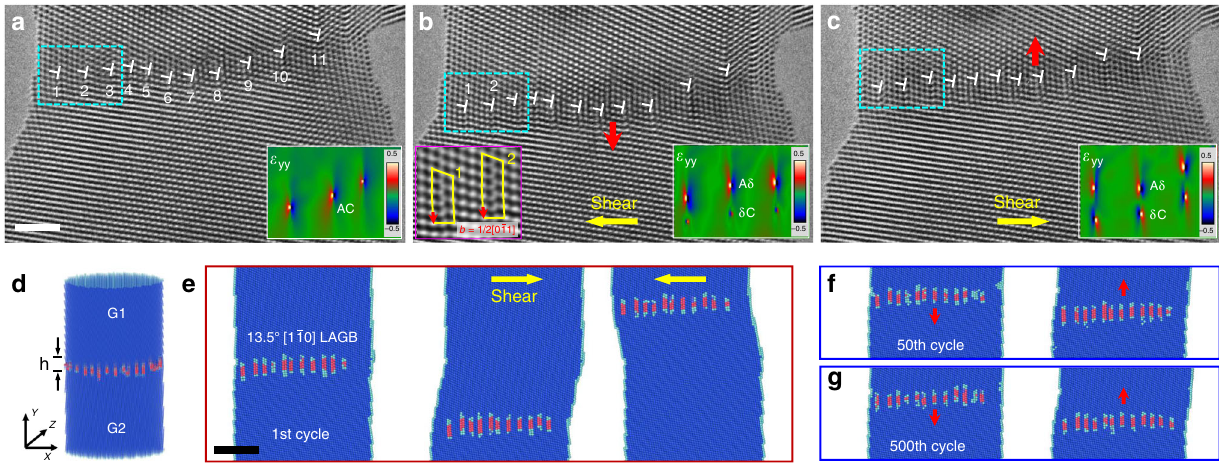
(cid:1) (cid:3) -- Fig. 2 Dissociation of the 13.5° 1 10 LAGB in fully reversed loading cycles. a – c Zoomed-in deformation snapshots showing the atomistic structure of the migrating 13.5° 1 (cid:1) 10 ½ (cid:2) LAGB in reversed shear loading. a Initial LAGB, consisting of well-aligned 1/2 01 (cid:1) 1 ½ (cid:2) dislocations with negligible dissociation. b , c GB migration associated with evident dissociations under leftward ( b ) and rightward ( c ) shear loading. The insets in a – c exhibit geometrical phase analysis (GPA) maps of the vertical normal strain ( ε yy ), demonstrating the dissociation of GB dislocations 1 – 3, as marked by the light blue rectangles. The zoomed- in TEM image in b shows the atomistic core structure of dissociated GB dislocations 1 and 2. d Perspective structure of a fully relaxed Au bicrystal with a dissociated 13.5° 1 (cid:1) 10 ½ (cid:2) LAGB (indicated by the arrows) constructed in molecular dynamics (MD) simulation at 300 K. The diameter and length of the bicrystal are 15 and 30 nm, respectively. e MD simulation snapshots demonstrating the reversible migration of the 13.5° 1 (cid:1) 10 ½ (cid:2) LAGB in a shear loading cycle. f , g Reversible deformation of the Au bicrystal with the 13.5° 1 (cid:1) 10 ½ (cid:2) LAGB in long-time shear loading cycles. The MD snapshots present well-retained LAGB- mediated reversible deformation in the f 50th and g 500th shear cycles, respectively. The cyan and red atoms indicate the Shockley partial dislocations and the stacking fault ribbons, respectively. Scale bars: a 2 nm and e 5 see inset of Fig. 2a). Upon deformation, the GB dislocations TEM image and evident strain dipoles in the corresponding GPA tended to dissociate into pairs of Shockley partial dislocations, map (see insets). The dissociated nature of the GB greatly (i.e., A δ + δ C ) on the coherent (111) slip planes of the top and facilitated the continual and correlated gliding of GB dislocations bottom grains (Fig. 2b and Supplementary Fig. 1), as con fi rmed inside the bicrystal, contributing to the fully reversible migration by the extended atomic con fi gurations in the high resolution of this LAGB (Fig. 2c).